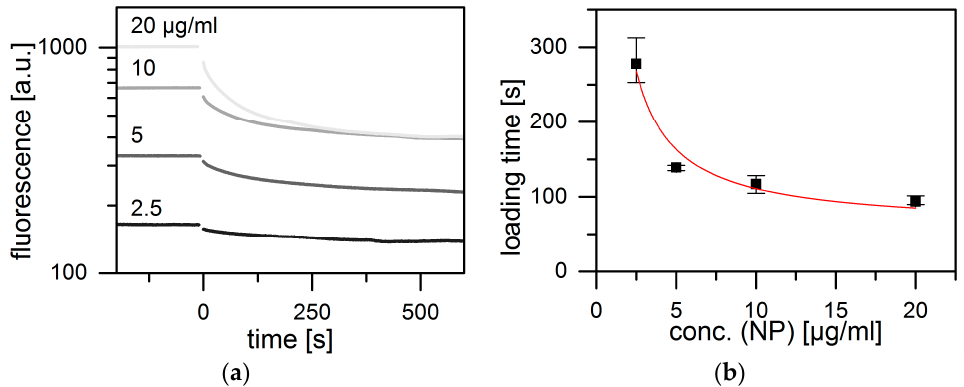
Figure 4. Fluorescence quenching in the time course of loading at various MIL-100(Fe) NP concentrations in HBG (pH 5.1) at fixed fluorescein to NP ratios. ( a ) Kinetics of the decay of fluorescein fluorescence after addition of NPs at time = 0. Time traces were fitted with single exponential decay; ( b ) The resulting loading times (in black) show a characteristic concentration dependency. This fits well with a model (red) involving a three-step process: free external diffusion, internal diffusion within the lattice and adsorption to the MOF network.